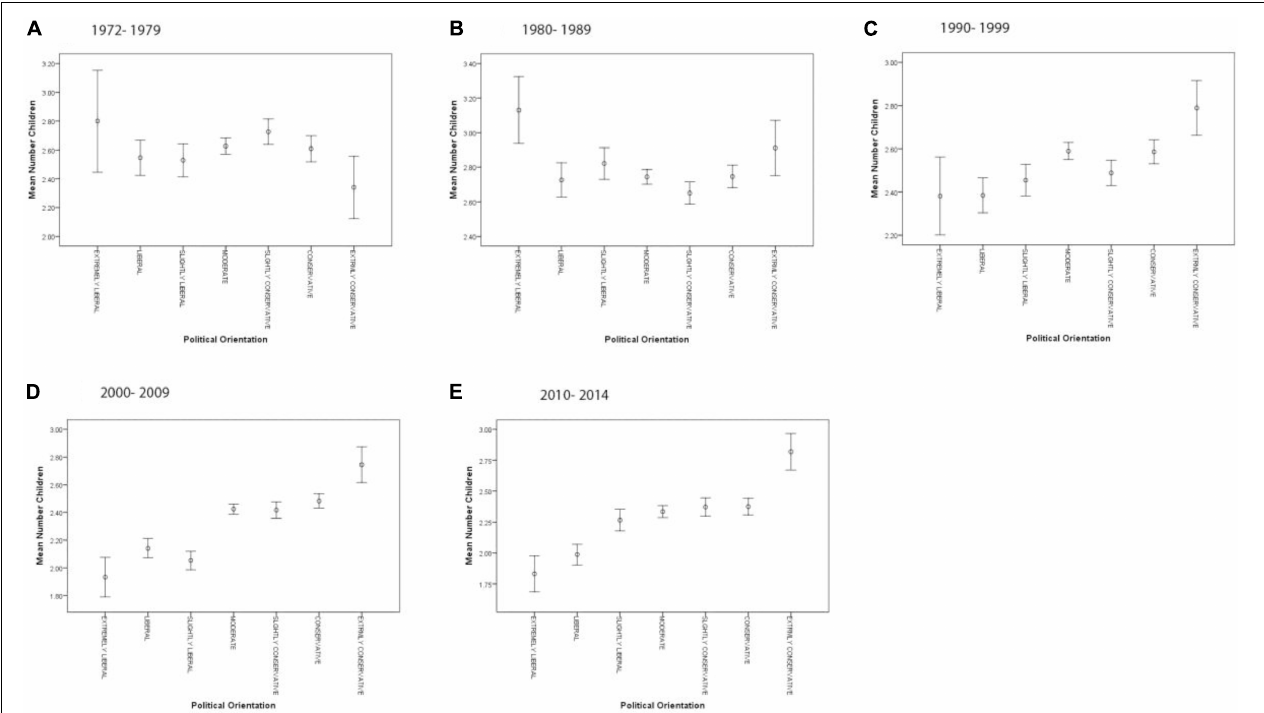
FIGURE 5 | (A–E) GSS: political orientation and mean number of children aggregated on survey decades.